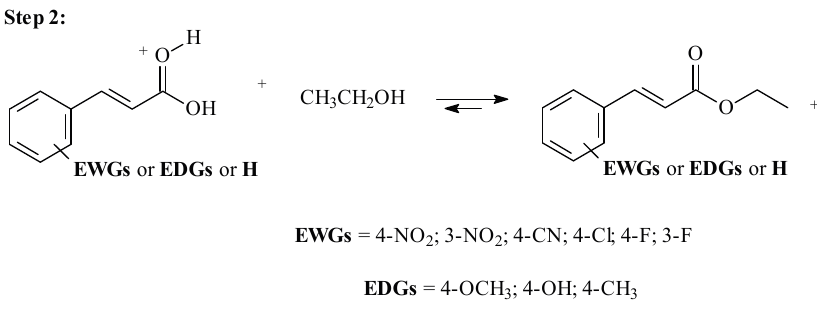
Figure 1. Steps for acid-catalyzed 4- or 3-X-cinnamic acid